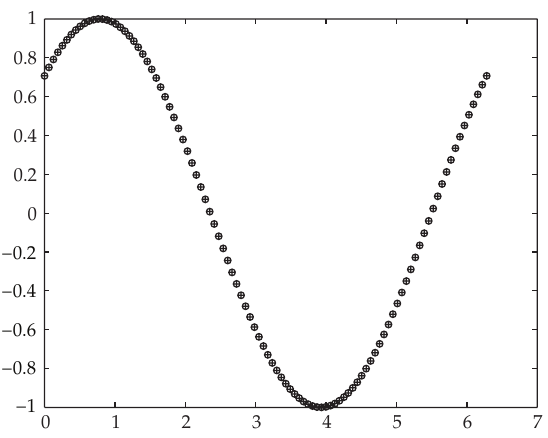
Figure 1: Index 1, T (cid:8) 2 π , the y -coordinate, “o”-original, “ (cid:9) ”-approximation.